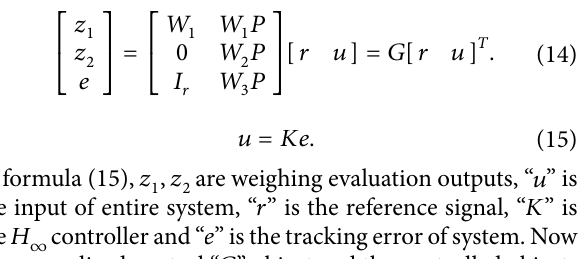
Figure 3: RST Controller based attitude control block